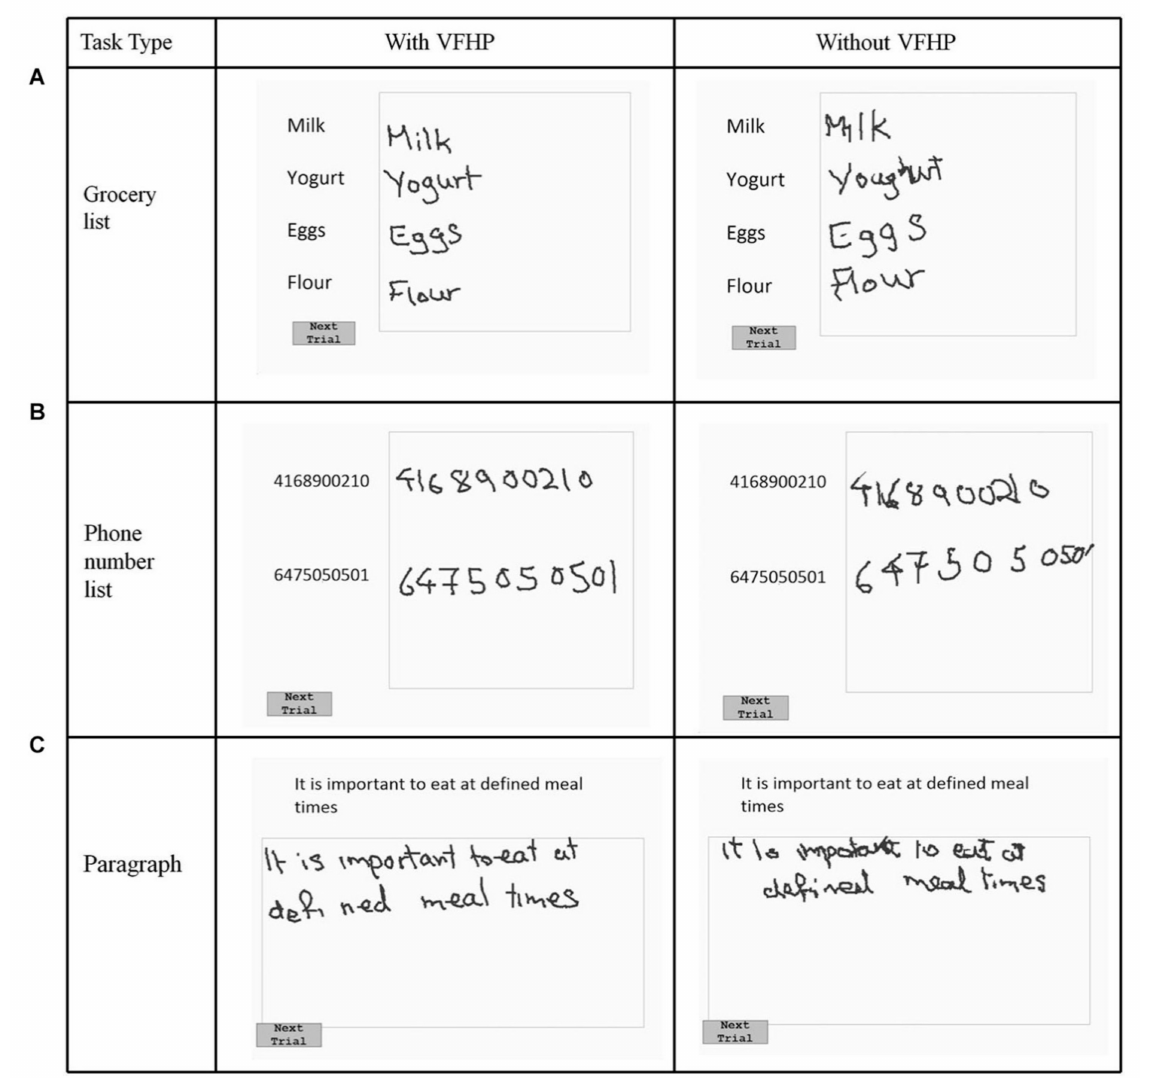
Figure 3. Visual stimuli and writing response sample of a writing experiment involving copying ( A ) a grocery list, ( B ) a phone number, ( C ) a paragraph using the fMRI-compatible tablet system with and without VFHP. The condition with VFHP achieved writing performance that was more clear, less cramped, and better positioned. VFHP = Visual Feedback of Hand Position. Taken from [17]. Copyright © 2015 Karimpoor et